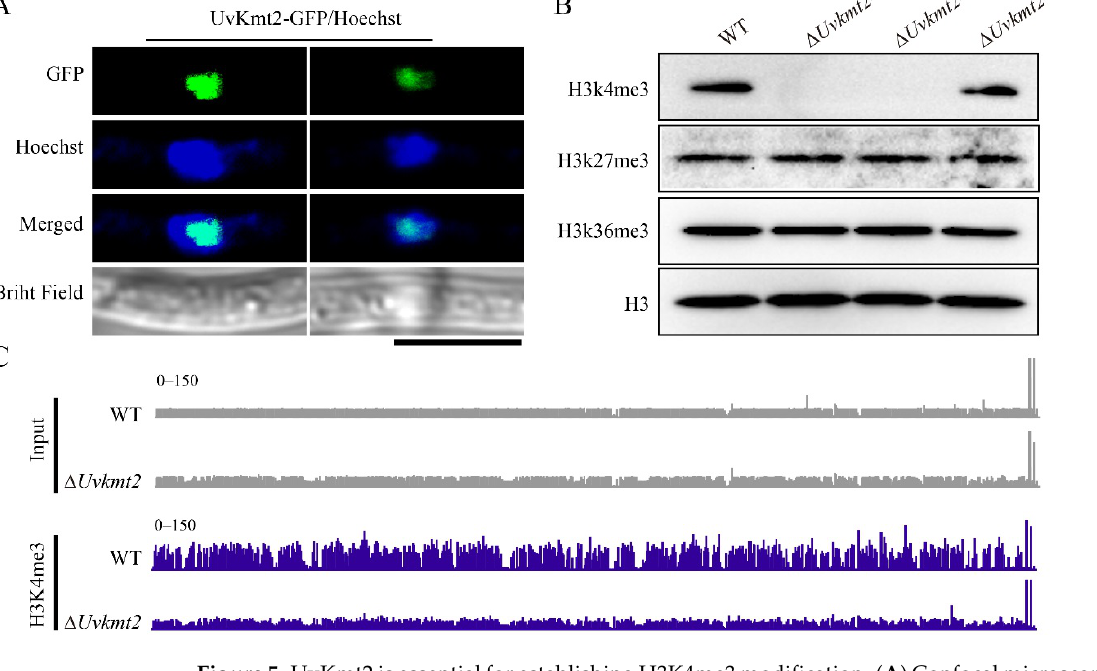
Figure 5. UvKmt2 is essential for establishing H3K4me3 modification. ( A ) Confocal microscopy-based subcellular localization of UvKmt2 fused with GFP. The GFP signal co-localized with Hoechst-stained nuclei. Scale bar = 5 µ m. ( B ) Deletion of UvKMT2 resulted in loss of H3K4me3 modification. Total nuclear proteins of WT, ∆ Uvkmt2 , and complemented strain ∆ Uvkmt2 -C were isolated to detect histone modification. Immunoblot assay were performed using H3, H3K4me3, H3K27me3, and H3K36me3 antibodies. ( C ) Genome browser views of H3K4me3 in the WT and ∆ Uvkmt2 mutant. H3K4me3-marked genomic sequences in the WT and ∆ Uvkmt2 were immunoprecipitated with H3K4me3 antibodies and then sequenced. The H3K4me3 enrichment was presented in the WT and ∆ Uvkmt2 strains. Similar results were obtained from two biological